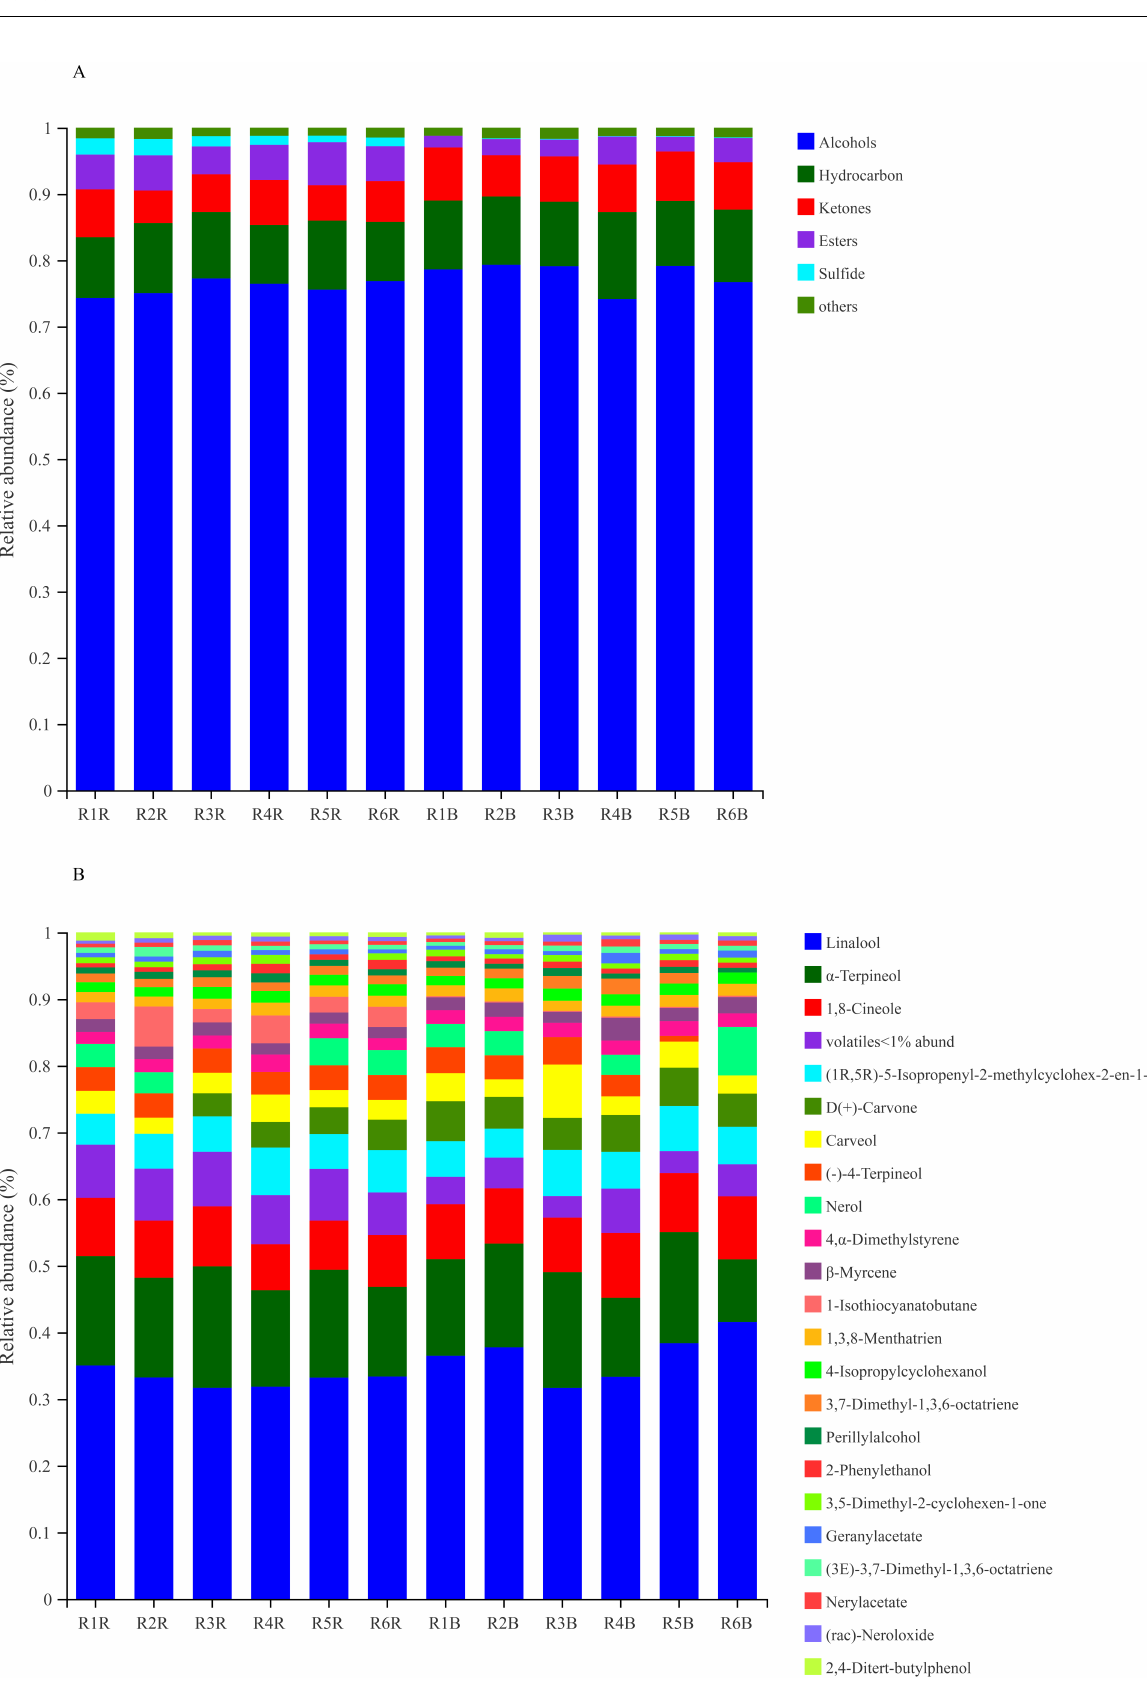
Figure 4. ( A ) Changes of VOCs in red radish paocai and cabbage paocai during fermentation. ( B ) Major VOCs with relative abundance of more than 1% of the red radish paocai and cabbage